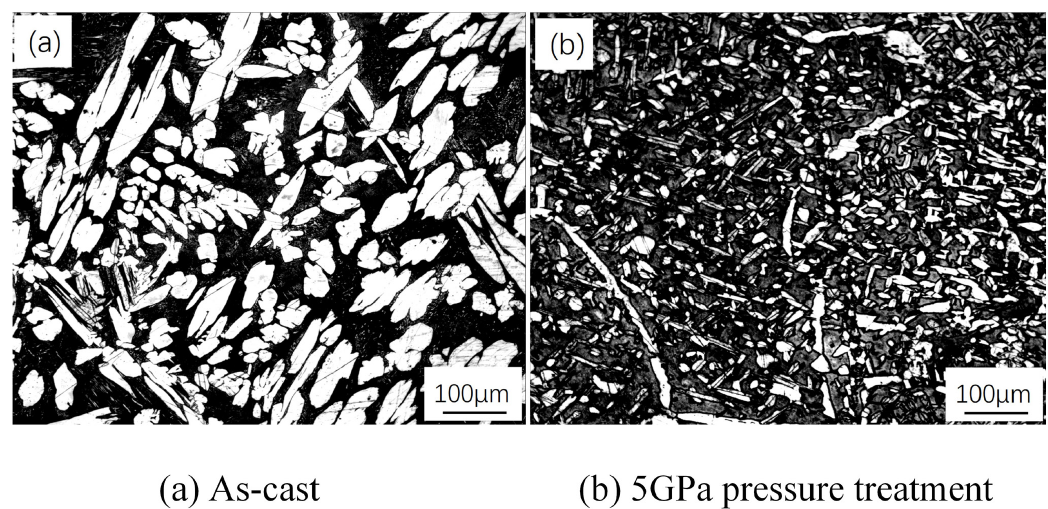
Fig.1 - Microstructure of Cu-Al alloy before and after high pressure